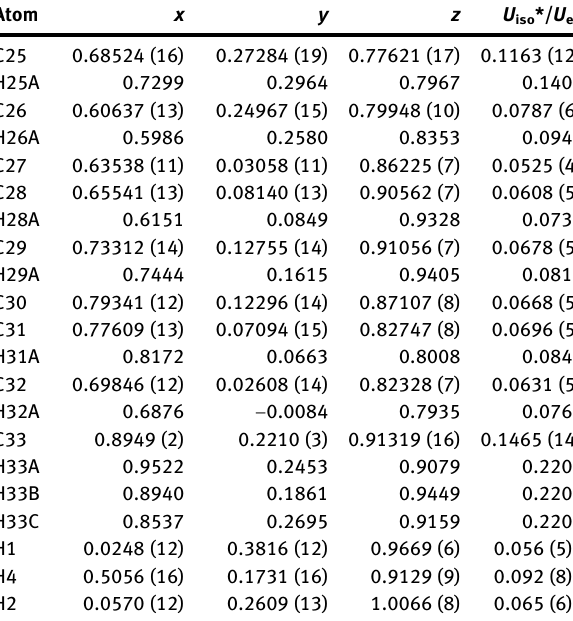
Table  : Fractional atomic coordinates and isotropic or equivalent isotropic displacement parameters (Å 